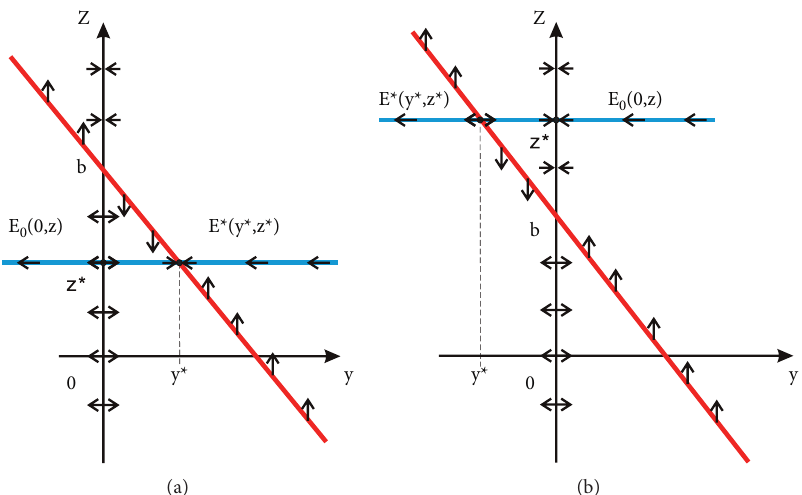
Figure 2: Representation of nullclines of system (9): horizontal direction z � z ∗ (in blue) and vertical direction z � my + b (in red); the vertical axis z ( y � 0 ) is a combination of both. Equilibrium points are indicated by black circles. (a) σ R − 1 > 0; (b) σ R and R 0